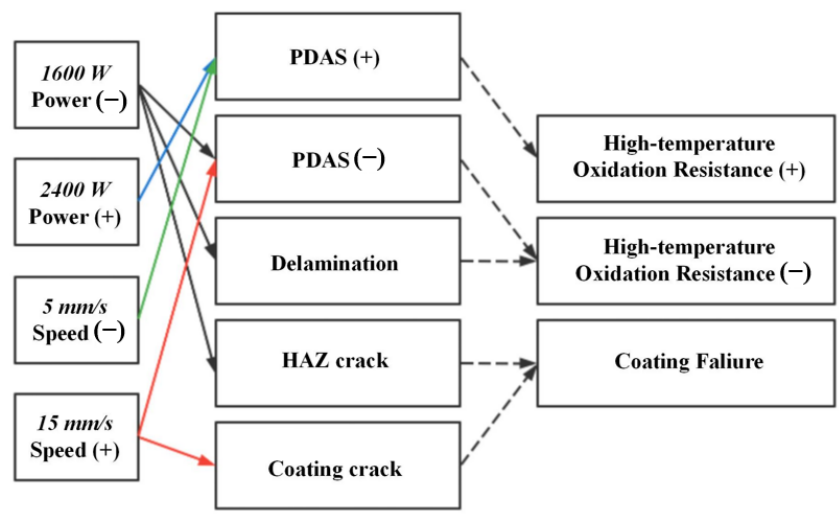
Figure 16. Effects of process parameter adjustment on high-temperature oxidation resistance.